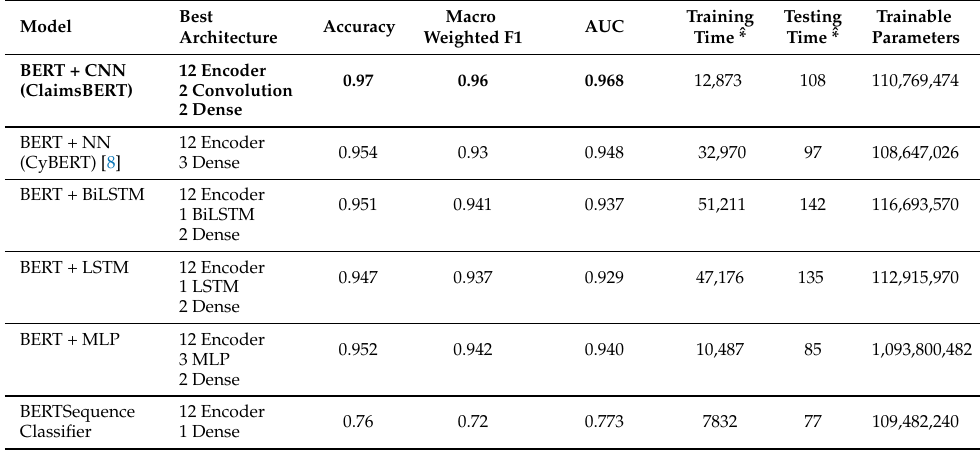
Table 10. Comparison across all tested